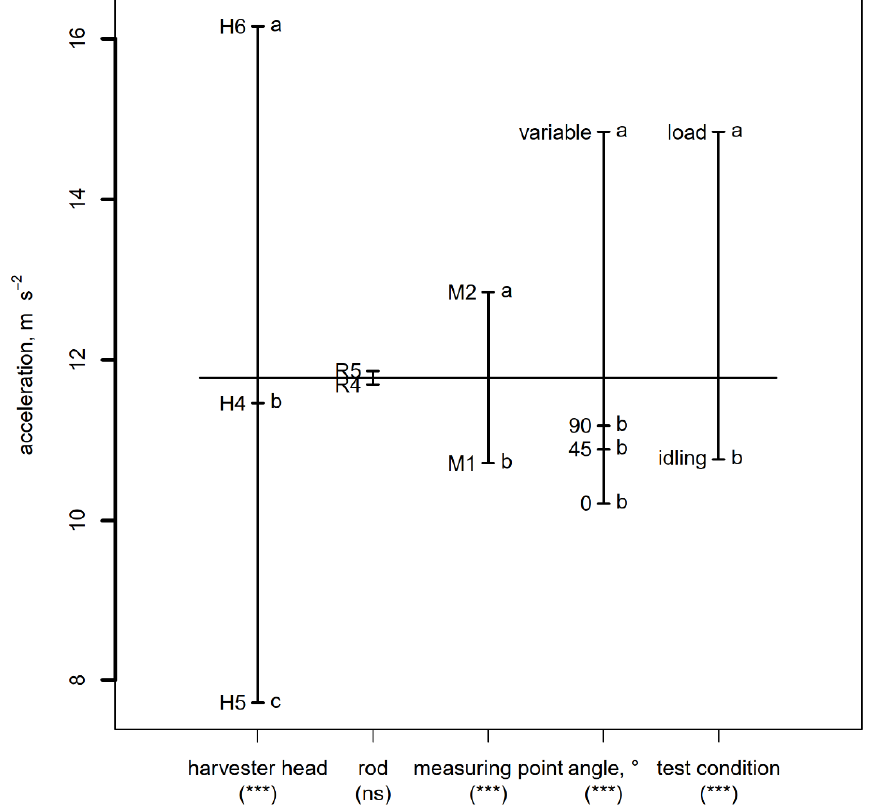
Figure 5. Mean acceleration total values with harvester heads H4–H6 according to the main fac- tors (mean separation by Kruskal–Wallis test at p = 0.05 level; (ns): differences not significant; (***): differences significant at p = 0.001 level). Table 6. Acceleration total values (m/s 2 ) with harvester heads H4-H6 (mean separation by Kruskal – Wallis test for each interaction: means with the same letter are not statistically different at p = 0.05 level).